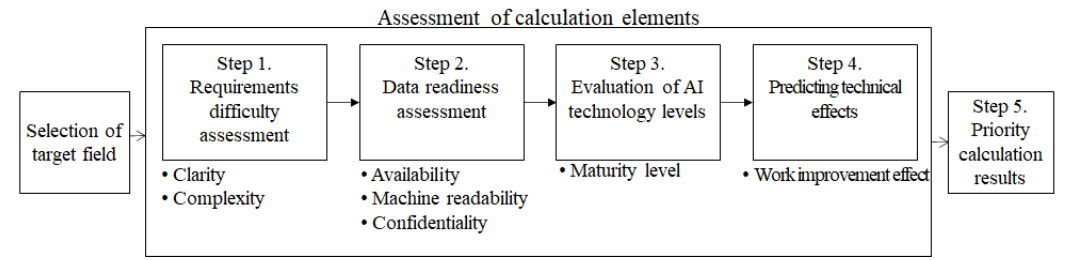
Figure 1. Procedure for applying AI.